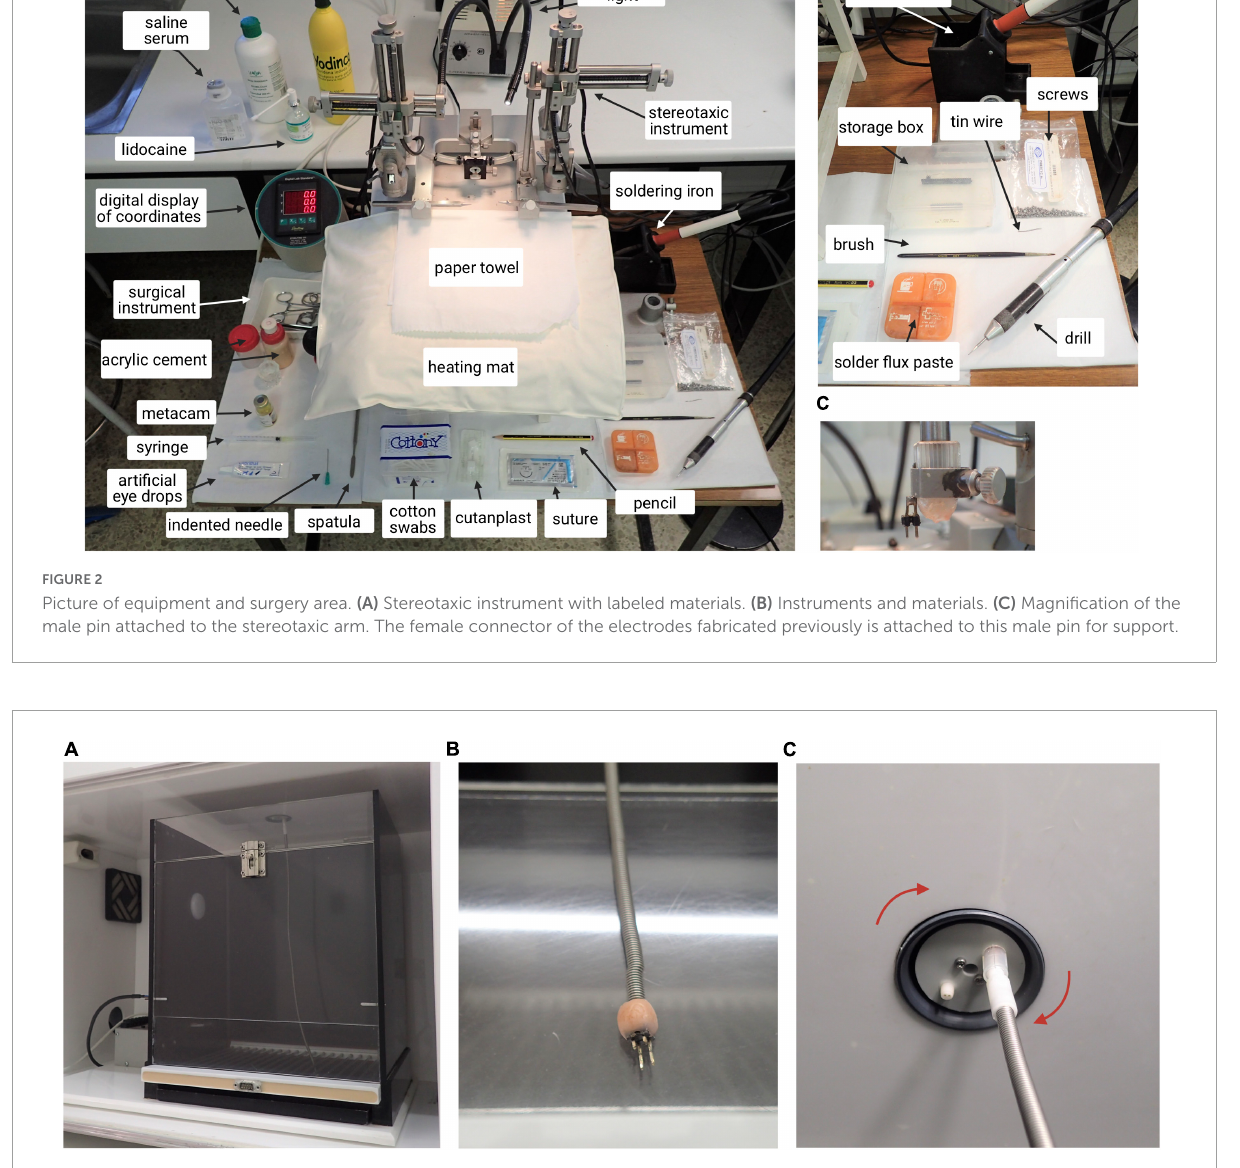
circuit is isolated optoelectronically. The duration of the trains can be adjusted (in this case we use 0.3 ms). The triggering of the train can be performed manually by a button or a response lever inside the Skinner box. The triggering signal is applied into an anti-rebound circuit